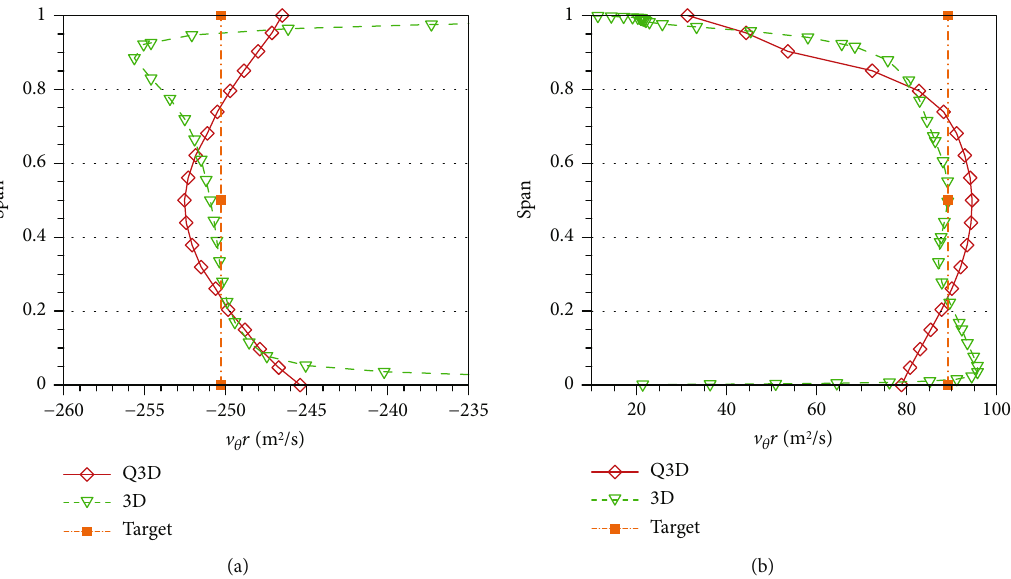
Figure 20: Swirl of the single-stage turbine: (a) stator; (b) rotor.